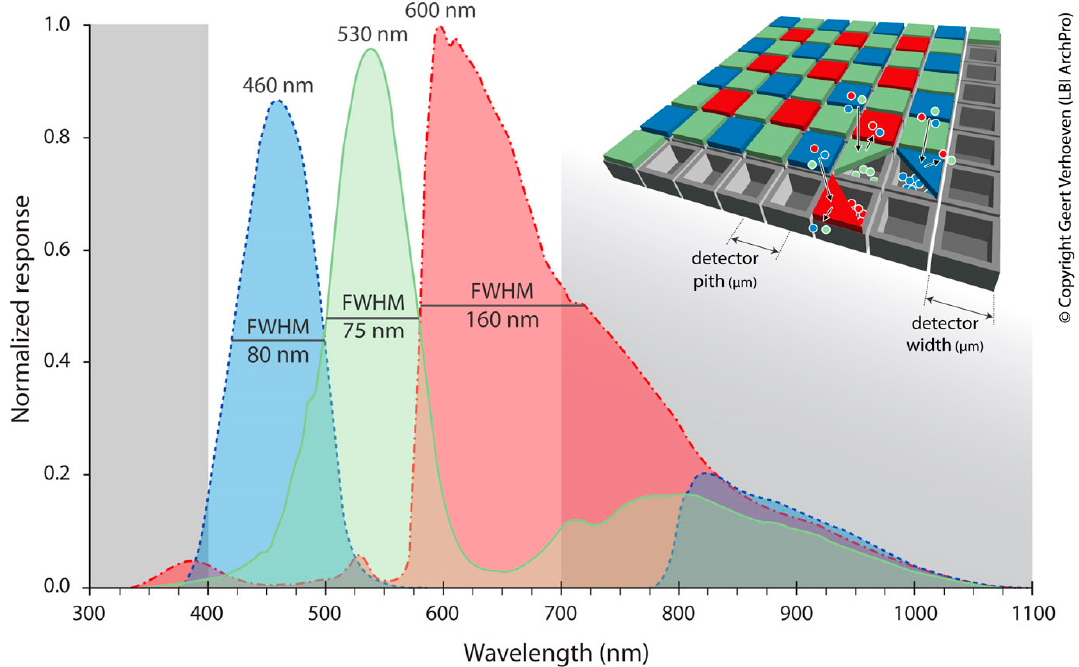
Figure 3. The working principles of a typical digital image sensor inside a photo camera. The relative spectral response curves obtained from a Nikon D200 without internal blocking filter reveal that the Blue, Green and Red channels have a FWHM of 80 nm, 75 nm and 160 nm, respectively. Note that the red channel of an unmodified camera will have a FWHM of about 50 nm since the camera will not be responsive in the invisible near-ultraviolet and near-infrared regions (both indicated in grey). With maxima at 460 nm, 530 nm and 600 nm, all bands are separated by 70 nm.